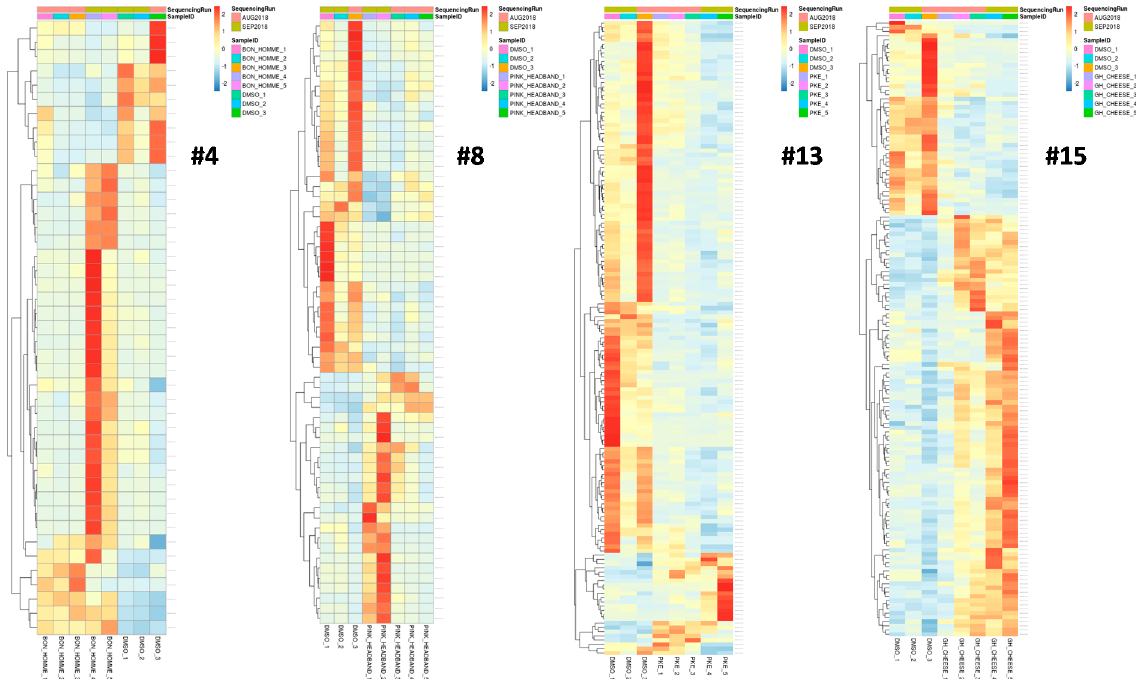
Figure 3. Heatmaps of the differentially expressed genes for Extracts #4, #8, #13 and #15. Five independent samples for the extracts and three independent samples for DMSO (control) are shown. Only genes with a p -value < 0.05 are shown. These experiments revealed that different extracts were efficient for different tissues.